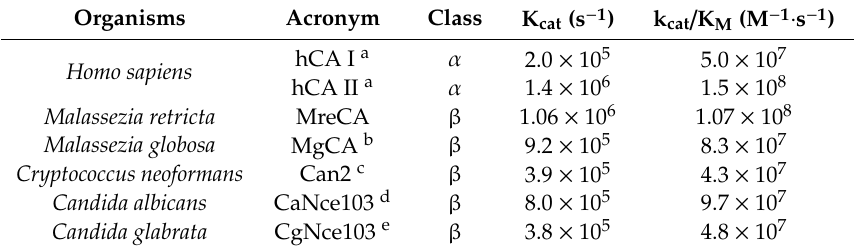
Table 1. MreCA kinetic parameters compared with those calculated for the two human isoforms hCA I and II ( α -class), and the fungal β -CAs from di ff erent species. The CO 2 hydration reaction was